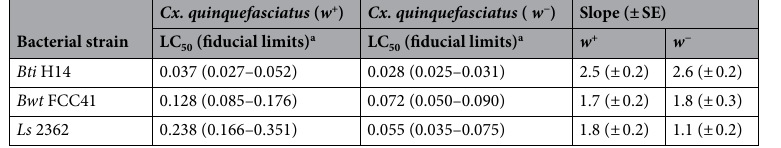
Table 1. Toxicity of Bacillus thuringiensis sp. israelensis ( Bti H14), Bacillus wiedmannii biovar thuringiensis ( Bwt FCC 41) and Lysinibacillus sphaericus ( Ls 2362) strains against Culex quinquefasciatus larvae infected with Wolbachia ( w + ) or treated with antibiotics ( w − ). a 24 hours mortality, in micrograms/milliliter. 95% confidential limits calculated by Probit statistical analysis. All values indicated were significantly different between mosquito lines according to ratio tests ( p <